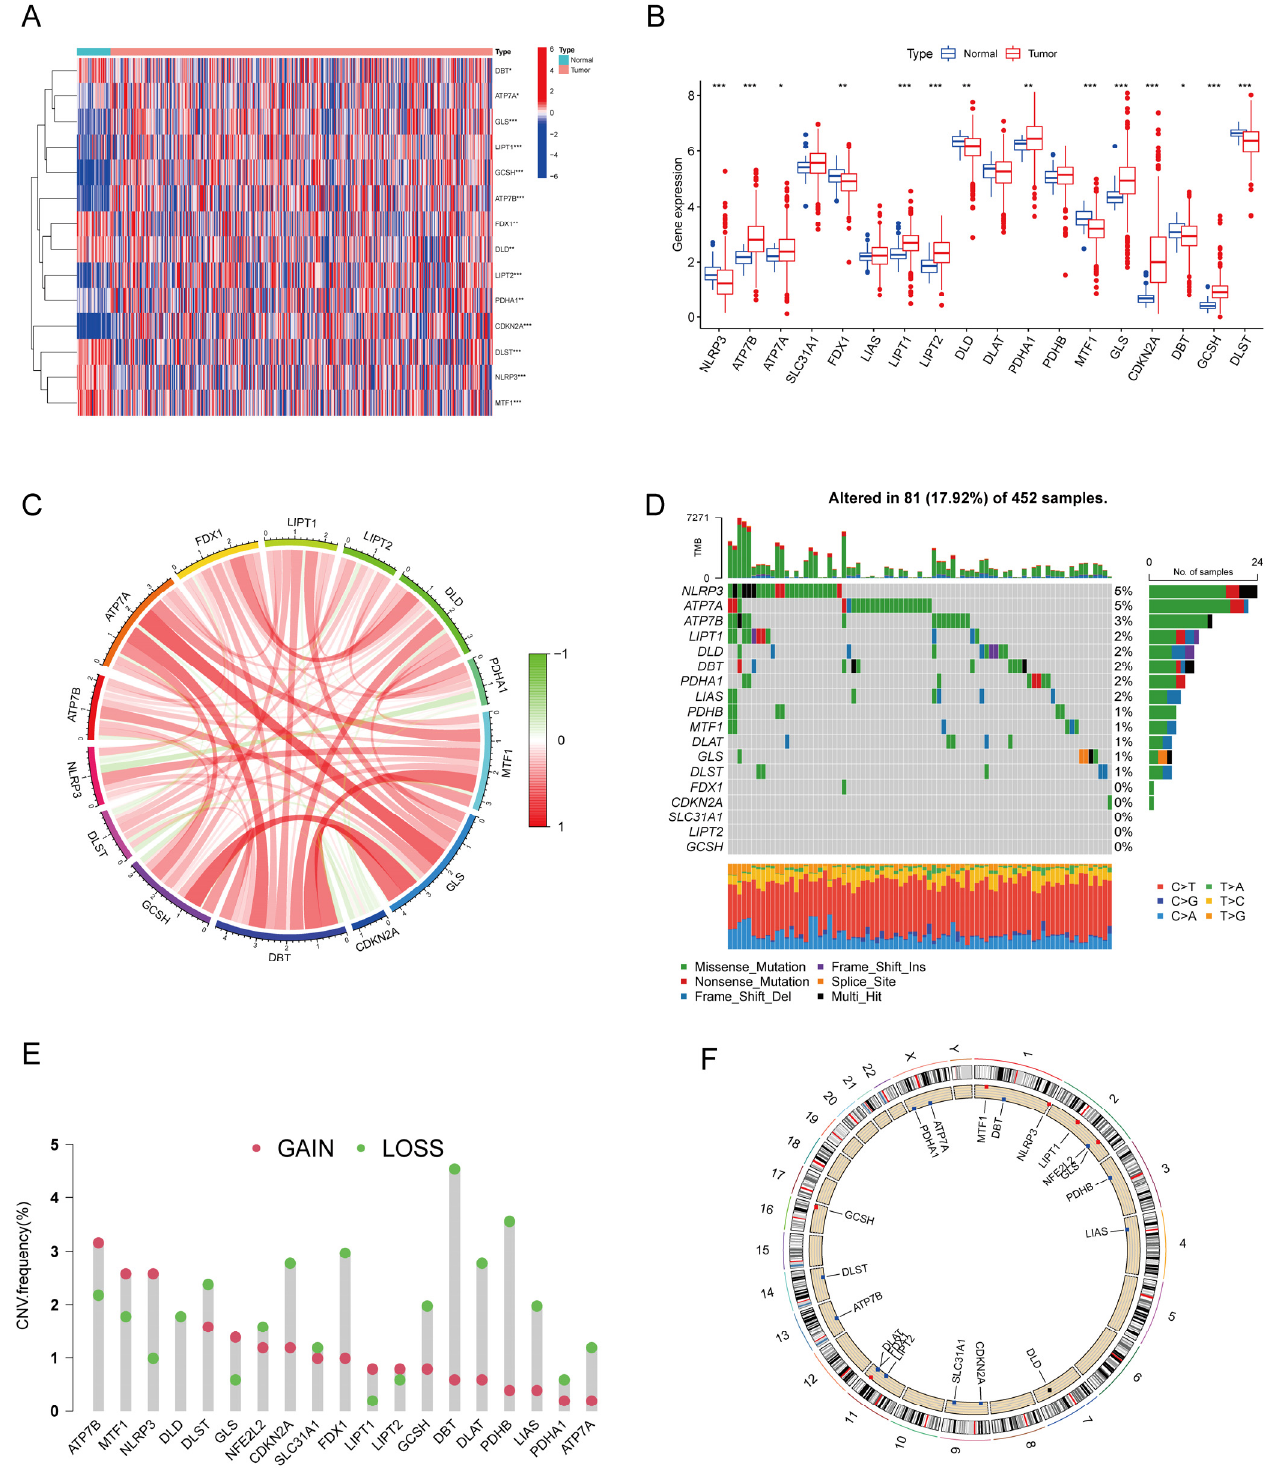
Figure 2. Expression levels and genetic variation in cuproptosis-associated regulators. Heatmap ( A ) and boxplot ( B ) of DECRs in colorectal cancer and normal tissues. ( C ) The association network shows the interactions between DECRs. Mutation frequencies ( D ) and copy number variant ( E ) of DECRs in colorectal cancer patients. ( F ) Location of DECRs on the chromosome. DECRs, differentially expressed cuproptosis-associated regulator, * p < 0.05; ** p < 0.01; *** p < 0.001.